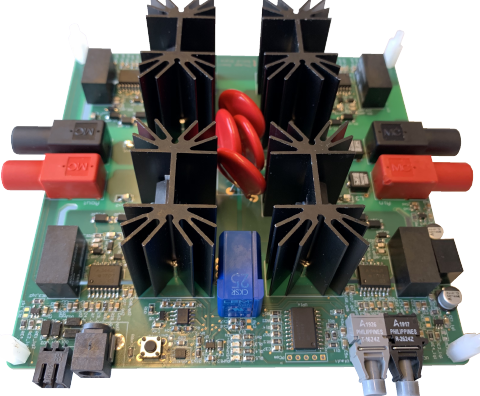
Figure 7. Hardware realization of the solid-state circuit